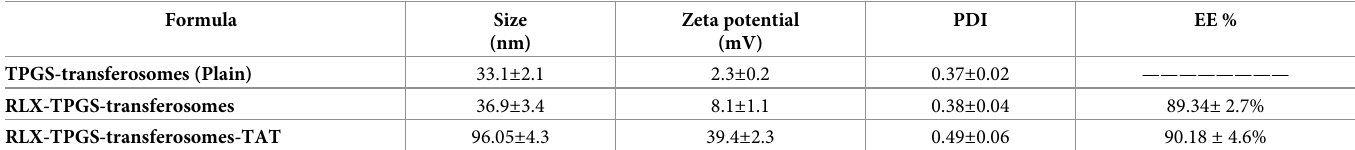
Table 1. Size, zeta potential, PDI and EE % of TPGS-transferosomes (Plain), RLX-TPGS-transferosomes and RLX-TPGS-transferosomes-TAT formulations. Results represents Mean ± SD.